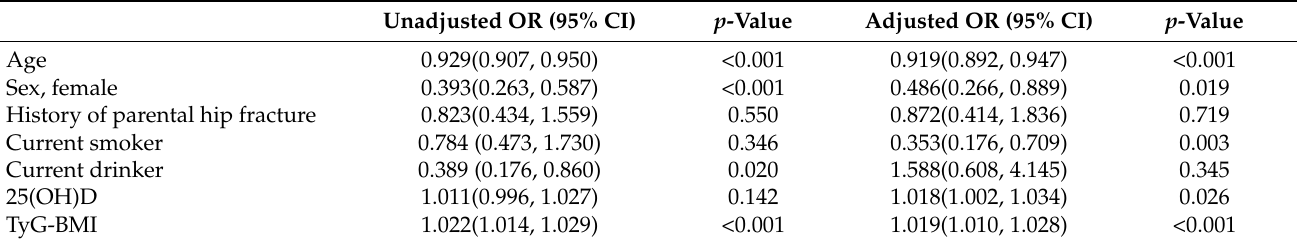
Table 5. Multivariable logistic regression analyses between possible predictors and osteoporosis. Adjusted with age, sex, 25(OH)D, current smoker, current